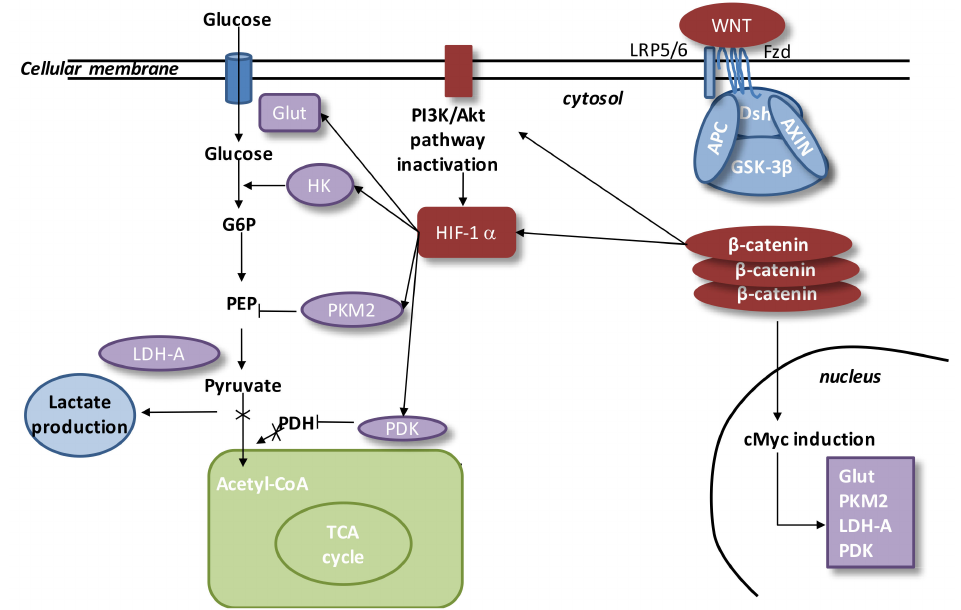
Figure 5. Interactions between the WNT pathway and aerobic glycolysis in exudative AMD. In exudative AMD, the WNT pathway is activated. In the presence of WNT ligands, cytosolic β -catenin is accumulated in cytosol and GSK-3 β is inhibited. APC and Axin combine with GSK-3 β and DSH to form a complex with LRP 5 / 6 and FZD . β -catenin translocates to the nucleus and binds to TCF / LEF co-transcription factor. WNT target genes such as cMyc are activated. β -catenin accumulation increases the level of the PI3K / Akt pathway and results in activation of HIF-1 α . Activated HIF-1 α stimulates Glut, HK, PKM2, LDH-A, and PDK1 . Activation of HIF-1 α involves PKM2 translocation to the nucleus. PKM2 activates the PEP cascade and the formation of pyruvate. PKM2 binds to β -catenin and induces cMyc-mediated expression of glycolytic enzymes ( Glut, LDH-A, PDK1 ). Activation of Glut and HK involves glucose hyper-metabolism with an increase in glucose transport and phosphorylation rates. PDK1 inhibits PDH and downregulates the pyruvate entrance into mitochondria. Lactate production is activated by LDH-A . This is the aerobic glycolysis. Abbreviations: tumor suppressor adenomatous polyposis coli ( APC ), dickkopf-related protein 1 ( DKK-1 ), glucose 6 phosphate ( G6P ), disheveled ( DSH ), hexokinase ( HK ), glycogen synthase kinase-3 β ( GSK-3 β ), lactate dehydrogenase A ( LDH-A ), glucose transporter ( Glut ), phosphoenolpyruvate ( PEP ), pyruvate dehydrogenase kinase ( PDK ), t-cell factor / lymphoid enhancer-binding factor ( TCF / LEF ), frizzled ( FZD ), low-density lipoprotein receptor-related protein 5 / 6 (LRP 5 / 6), and tricarboxylic acid cycle ( TCA